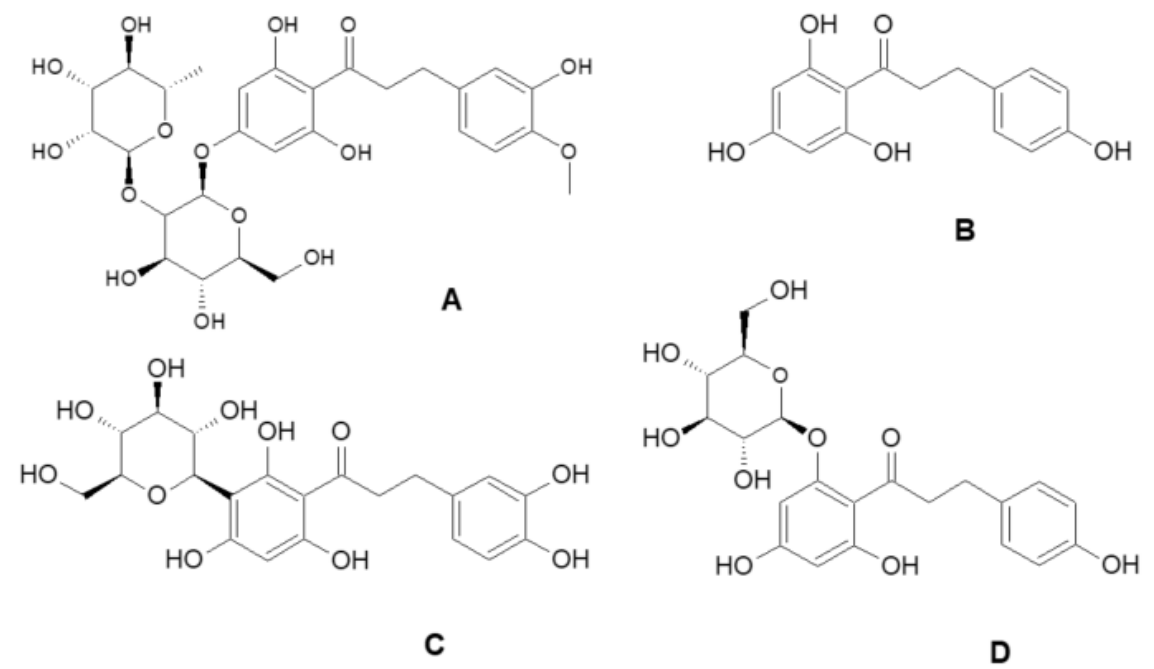
Figure 1. Structure of dihydrochalcones: neohesperidin dihydrochalcone ( A ), phloretin ( B ), aspalathin ( C ) and phloridzin ( D ).